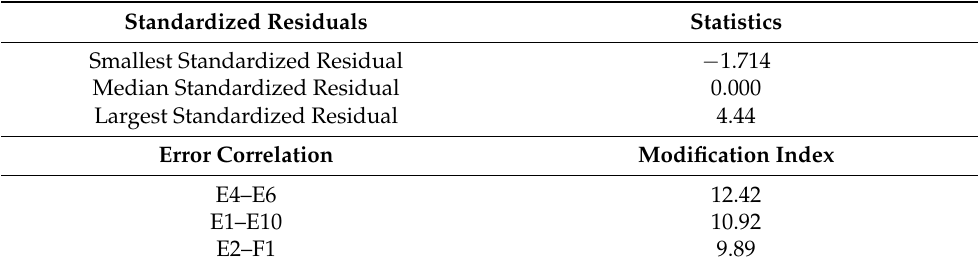
Table 6. Summary Statistics for Standardized Residuals and Largest Modification Indexes for Model